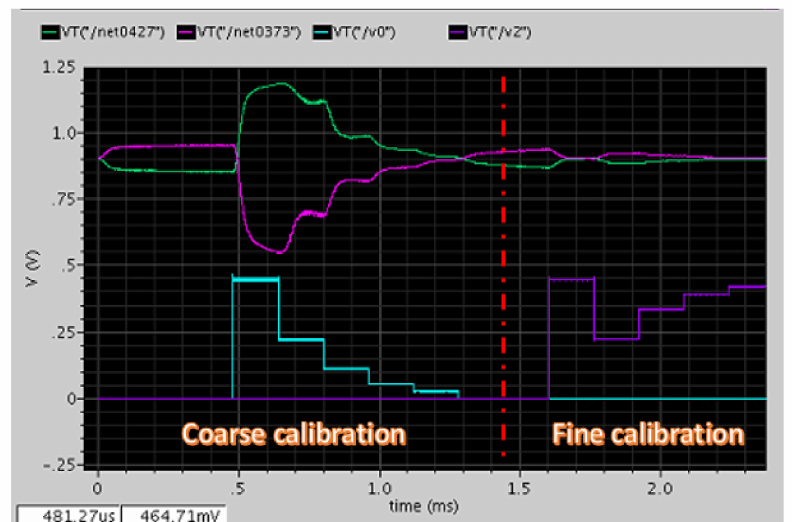
Figure 20. After the two cascading RC filters.